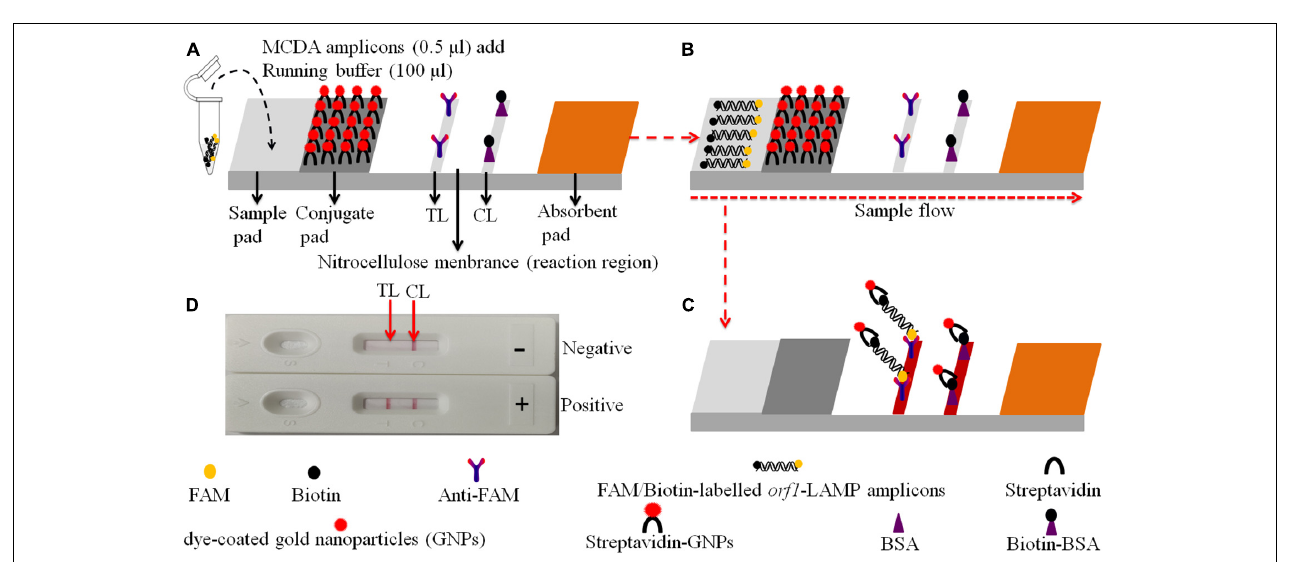
FIGURE 2 | Schematic of the gold nanoparticle-based LFB for N. gonorrhoeae -MCDA product visualization. (A) MCDA products (0.5 µ l) and running buffer (100 µ l) were deposited on the sample pad. (B) The running buffer containing MCDA products moves along the LFB due to capillary action, while streptavidin dye-coated gold nanoparticles (streptavidin-DPNs) are rehydrated in the conjugate region. (C) For positive samples, FAM/biotin-labeled orf1 -MCDA amplicons are captured by anti-carboxyfluorescein (FAM) at the test line (TL), and streptavidin-DPNs are captured by biotin-BSA at the control line (CL). For negative outcomes, only streptavidin-DPNs are captured by biotinylated bovine serum albumin (biotin-BSA) at the CL. (D) Interpretation of N. gonorrhoeae -MCDA-LFB assay results; positive – CL and TL appear on the LFB, and negative – only the CL appears on the